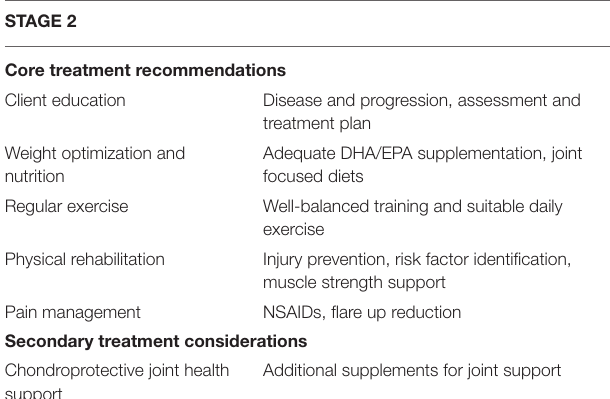
TABLE 2 | Summarized core and secondary treatment recommendations for COAST Stage